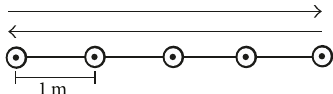
Figure 4: Edgren Side Step Test